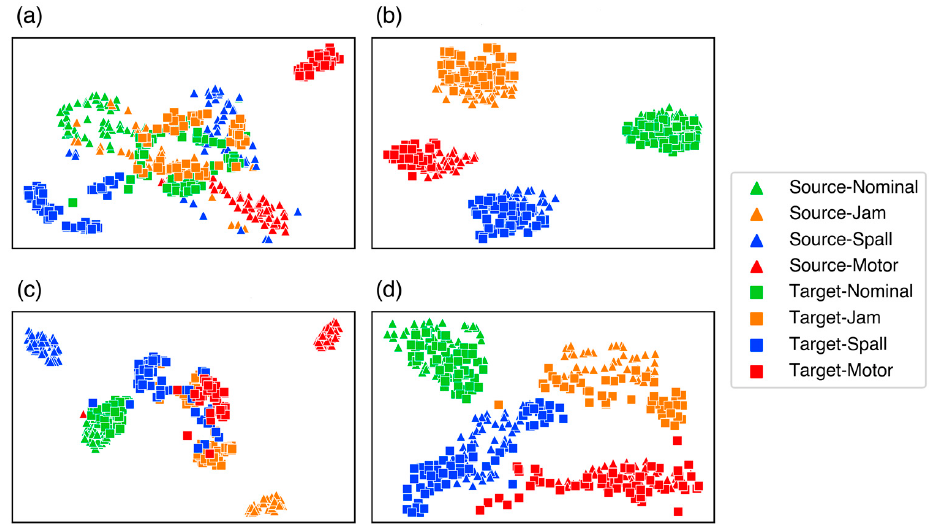
Figure 7. Visualizations of the high-level features. (a) Task T3d | CNN; (b) Task T3d | ETJ; (c) Task T1c | CJ; (d) Task T1c | ETJ.